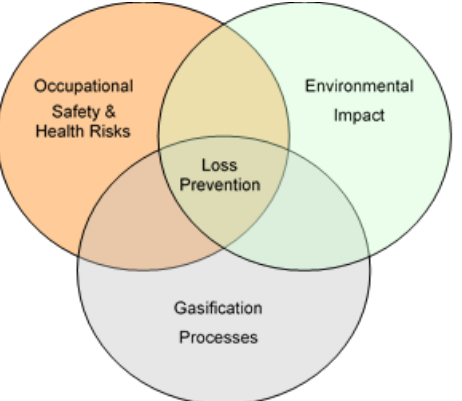
Figure 2. Scope of this review: associations between gasification processes and both OSH and environmental